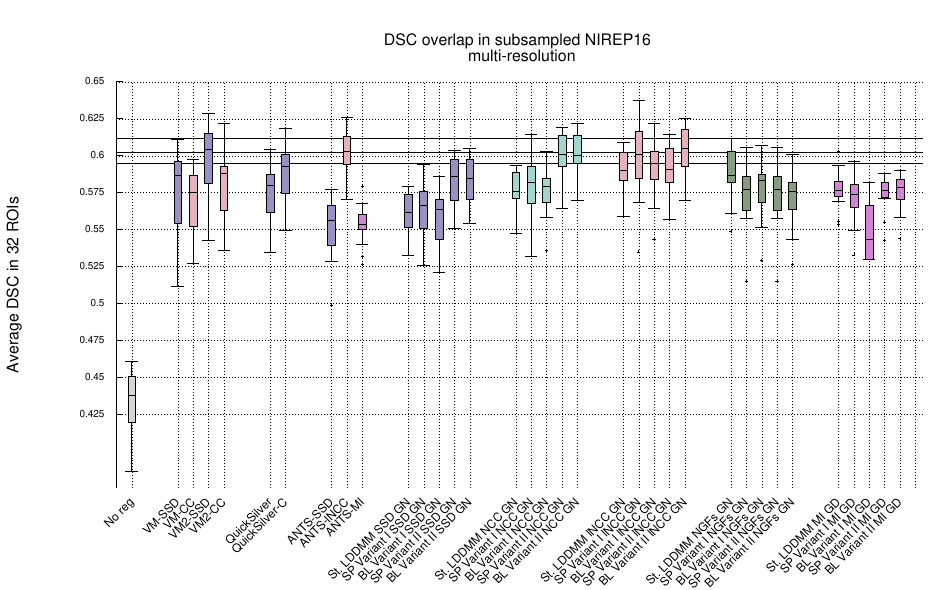
Figure 2. NIREP16. Same legend to Figure 1. Results obtained with PDE-LDDMM and Gauss– Newton–Krylov optimization. Boxplots grouped by variant. St-LDDMM is grouped with PDE- LDDMM results for facilitating comparison. Table 1. NIREP16. Multi-resolution experiments and Gauss–Newton–Krylov optimization. Results of ANOVA tests for the effects of method and image similarity metric